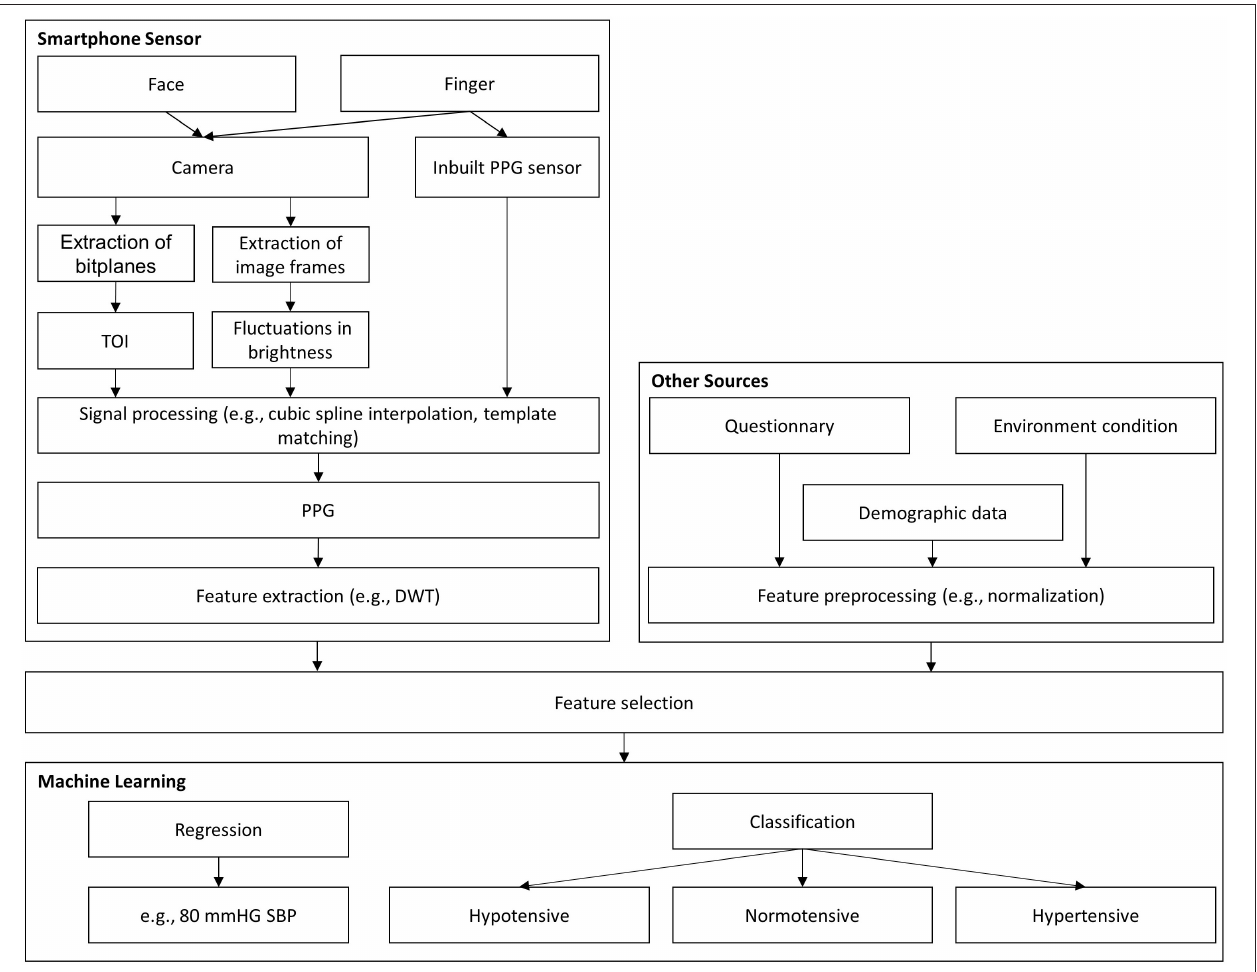
FIGURE 2 | Graphical abstract for BP assessment. DWT, discrete wavelet transformation; PCA, principal component analysis; PPG, photoplethysmography; TOI, transdermal optical imaging; SBP, systolic blood